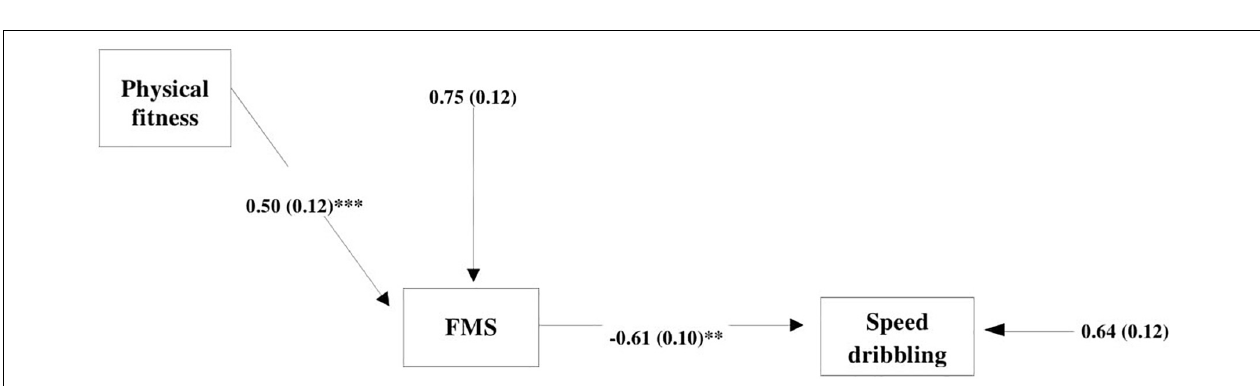
FIGURE 2 | First path analysis model with direct and indirect effects of physical fitness and FMS on speed dribbling [Satorra–Bentler χ 2 ( df = 0) = 0; p = 0.00; RMSEA = 0.0; SRMR = 0.0; CFI = 0.0; TLI = 0.0]; FMS, fundamental motor skills. ∗∗ p < 0.01; ∗∗∗ p < 0.001.